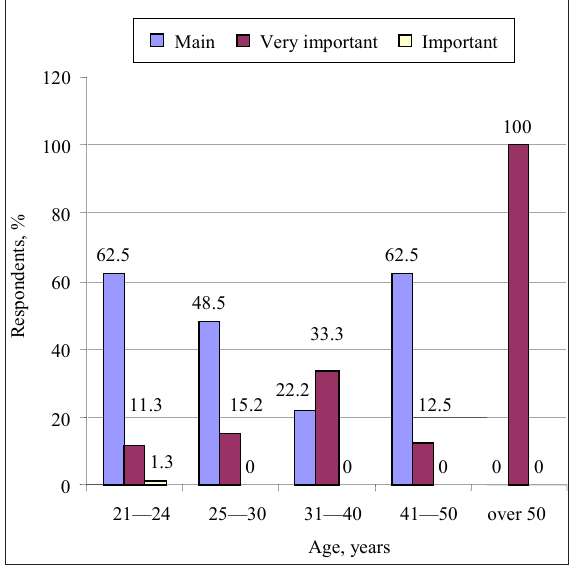
Fig. 1. Career as a motive for respondent groups of various age Fig. 2. Career as a study motive referring to